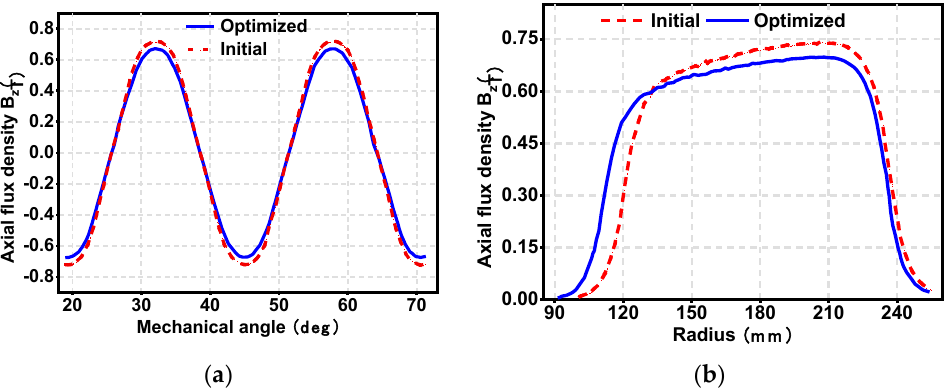
Figure 7. The air-gap flux density of the SCM-AFPM motors. ( a ) The z -directional component of the